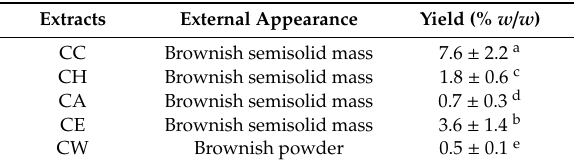
Table 1. External appearance and yields of C. militaris extracts.